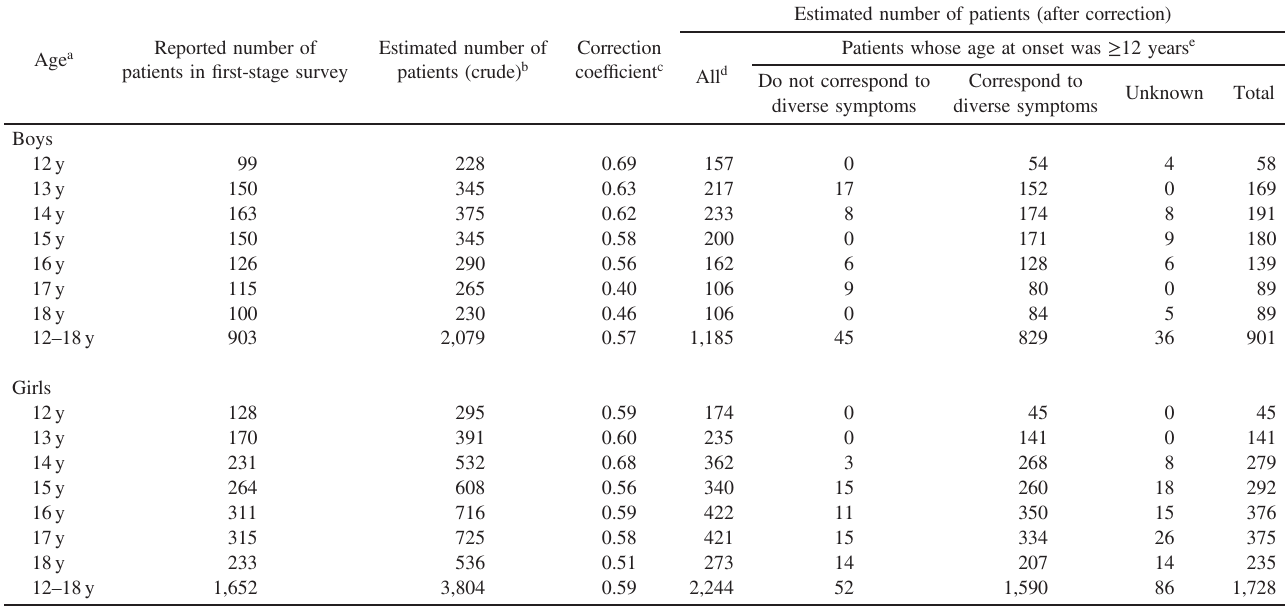
Table 3. Estimated gender- and age-speci fi c number of patients with diverse symptoms during the period of July to December 2015